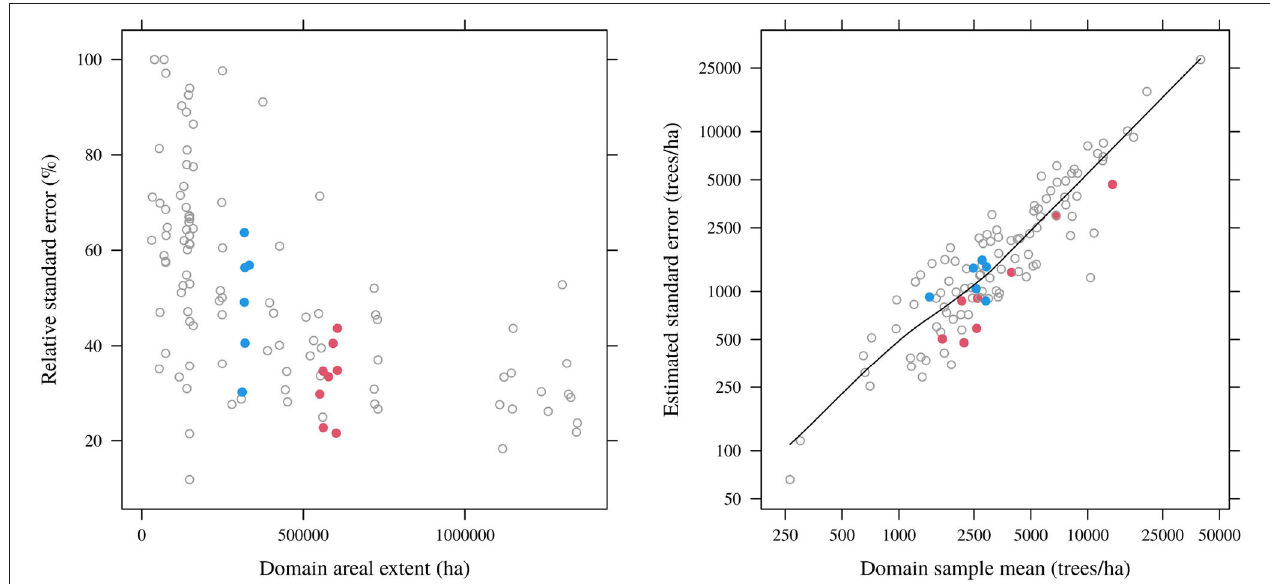
FIGURE 3 | Relationships between estimated relative standard errors of domain sample means and domain areas (left) and between estimated standard errors and domain sample means (right; log scale). Only results for 10-year domains (any lags) and domain sample sizes above 2 are shown.